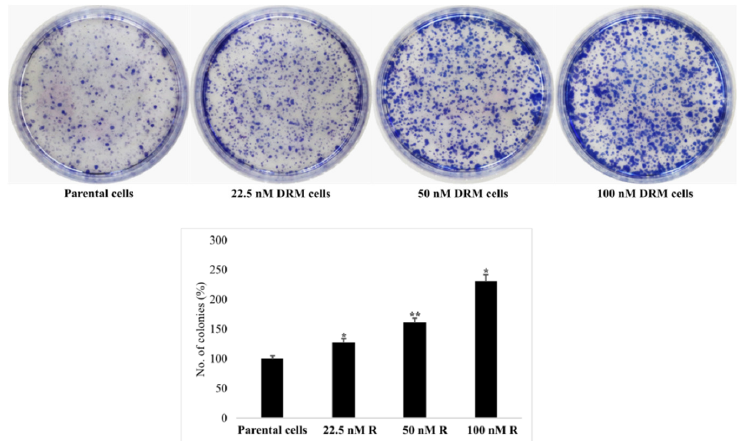
15%, and 58%, respectively (Figure 5). The adhesion of DRM cells to endothelial cells (ECs)